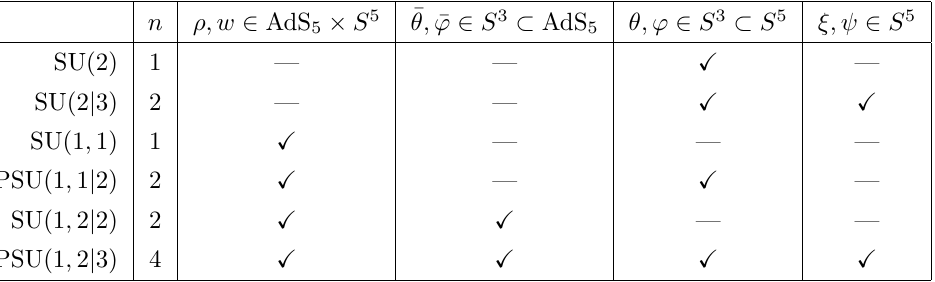
Table 3 . The 2 n ‘flat’ directions for each sector and their AdS 5 × S 5